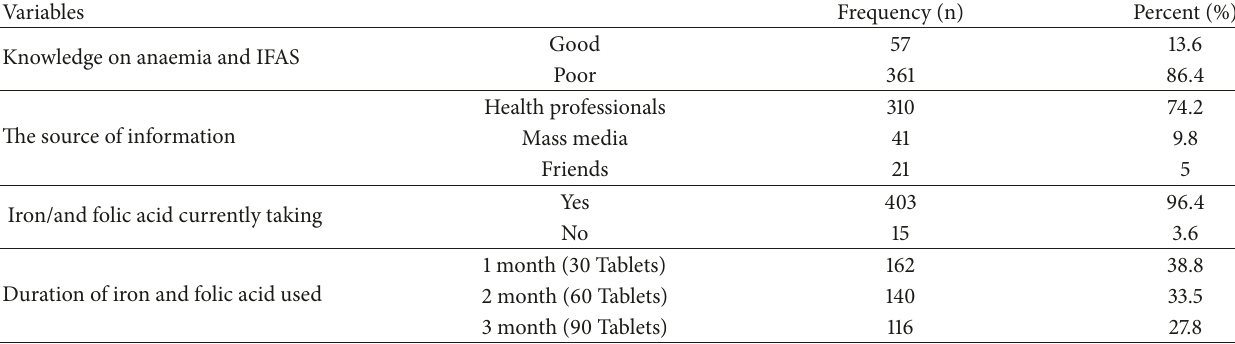
Table3:Respondents’knowledgeofanaemiaandbenefitofIFASinLayArmachihodistrictHealthCenters,NorthwestEthiopia,2017(n=418).